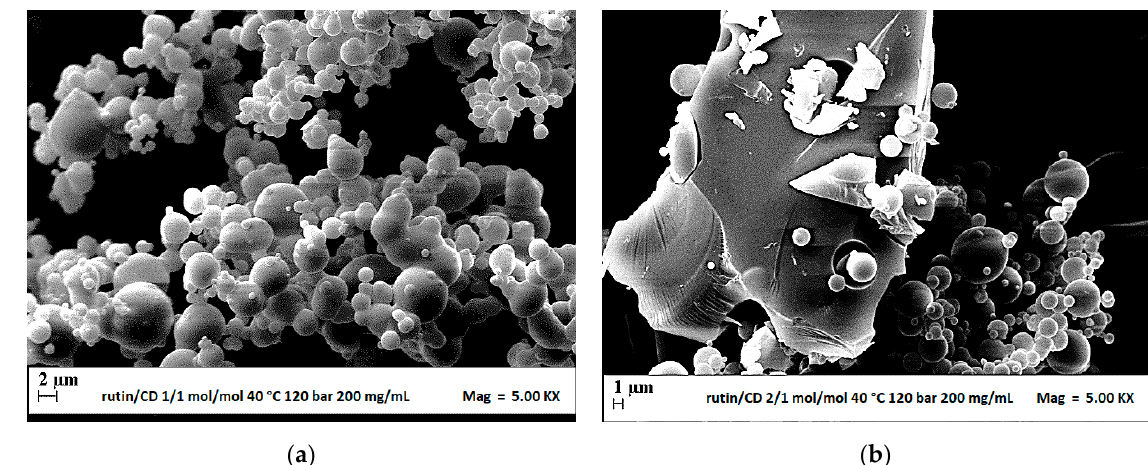
Figure 6. FESEM images of ( a ) microparticles RUT– β‐ CD 1:1 mol:mol (run #9), ( b ) microparticles and crystals at RUT– β‐ CD 2:1 mol:mol (run #10), precipitated from DMSO at 40 °C, 200 mg/mL and 12 MPa.